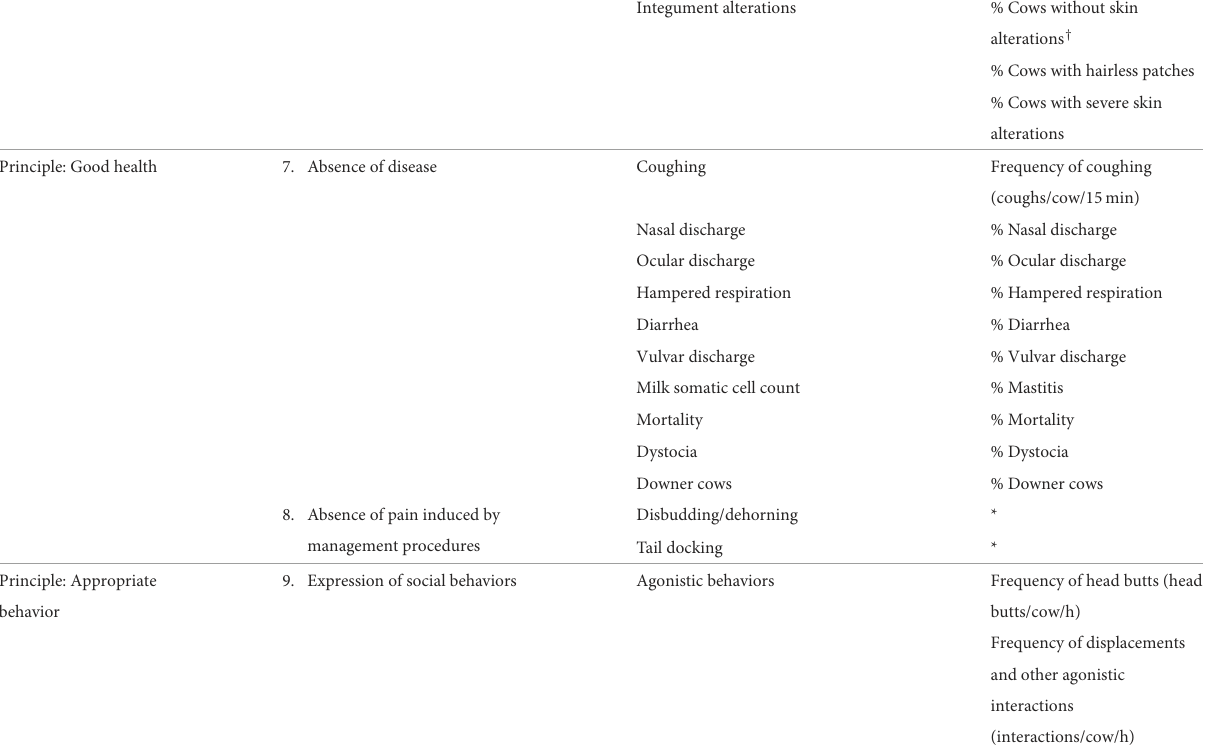
level expressions used for